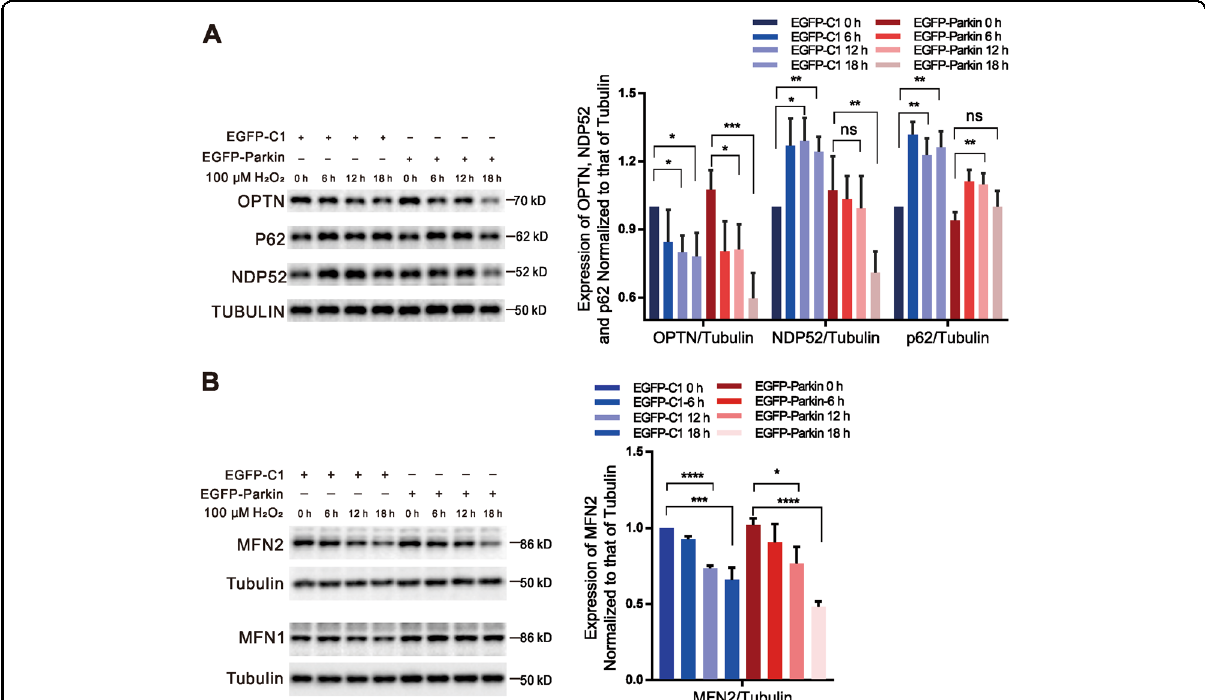
Fig. 2 H 2 O 2 induction modulates mitophagy-associated protein levels. A Cells were transfected with the EGFP-C1 (as a control) or EGFP-Parkin plasmids. Twenty-four hours later, the cells were treated with 100 μΜ H 2 O 2 for 0 h, 6 h, 12 h, or 18 h. The levels of the mitophagy-associated proteins OPTN, NDP52, and p62 were evaluated by WB analysis. N = 4; ns, not signi fi cant; * P < 0.05; ** P < 0.01; *** P < 0.001. Data from four independent tests were collected for statistical analysis (mean ± SD). B Cells were transfected with the EGFP-C1 or EGFP-Parkin plasmids. Twenty-four hours later, the cells were treated with 100 μΜ H 2 O 2 for 0 h, 6 h, 12 h, or 18 h. The levels of MFN2 and MFN1 were evaluated by WB analysis. N = 3; * P < 0.05; *** P < 0.001; **** P < 0.0001. Data from three independent tests were collected for statistical analysis (mean±